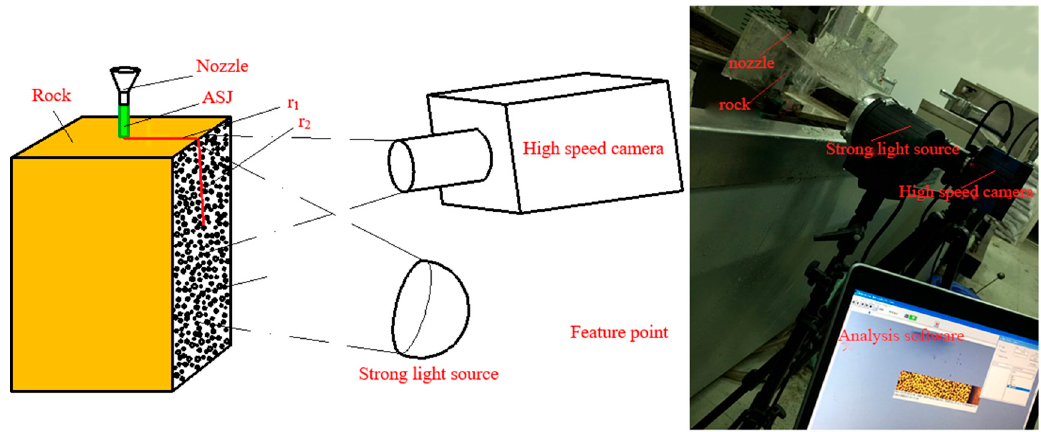
Figure 2. Schematic diagram and real image of the non-contact strain measurement system.